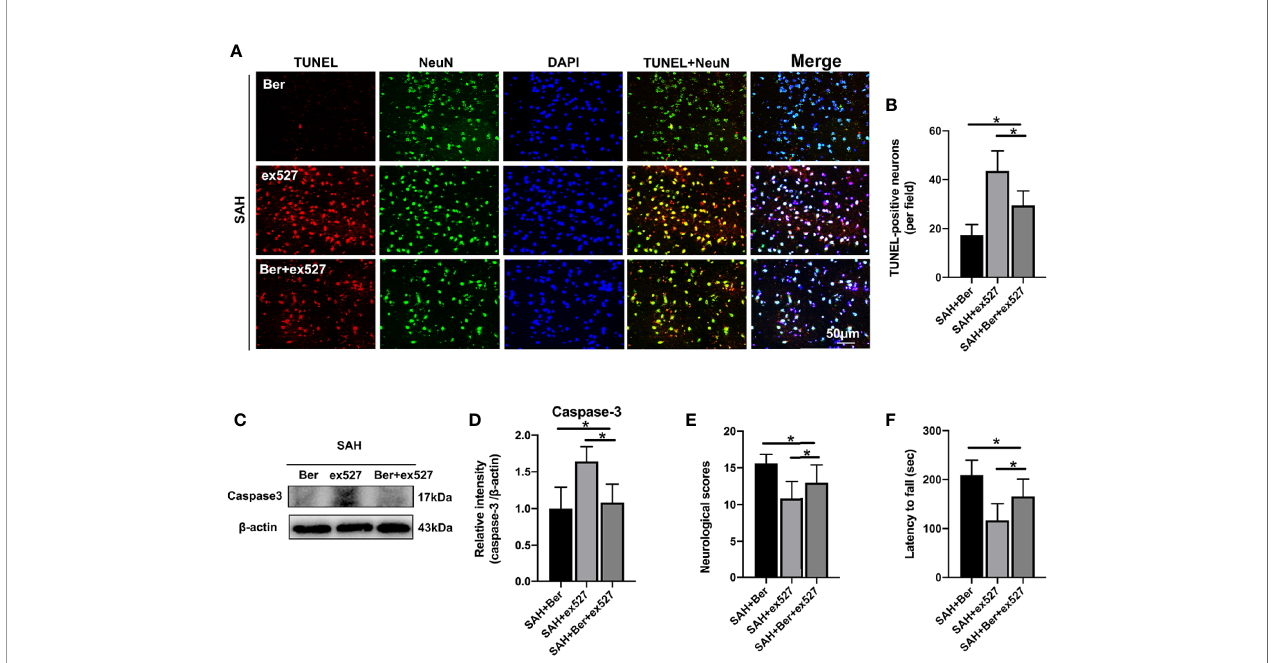
FIGURE 6 | Effects of ex527 on neural apoptosis and neurological behavior after SAH. (A, B) Representative photomicrographs (A) and quanti fi cation (B) of TUNEL staining. n = 6 per group. (C, D) Western blot assay (C) and quanti fi cation for the expression of caspase-3 (D) in the indicated groups. n = 6 per group. (E, F) Effects of ex527 on neurologic scores (E) and rotarod performance (F) at 24 h after SAH. n = 12 per group. Bars represent the mean ± SD. * P <